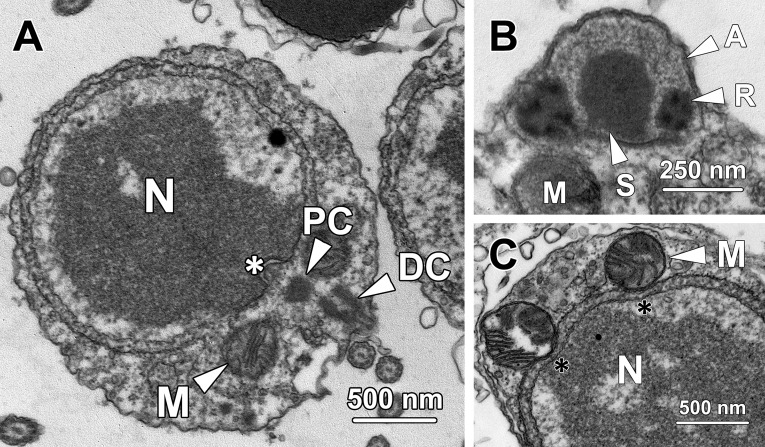
Transmission electron micrographs of step 7 spermatids.(A) The chromatin in the nucleus of step 7 spermatids exhibits a coarse granular form and aggregates into a large irregular-shaped block. The chromatin block attached to the posterior end of the nucleus (N), where an implantation fossa (*, white asterisk) has formed. The proximal centriole (PC) remains in close proximity to the fossa and orientates perpendicularly to the distal centriole (DC). The large spherical-shaped mitochondria (M) become surrounded the centrioles and start to form the mitochondrial sheath at the base of the flagellum. (B) The acrosome (A) transforms into an inverted-bowl shape with its anterior region tightly adherent to the cell membrane. In the acrosomal matrix, both the central sphere (S) and the ring-shaped structure (R) attach to the inner posterior membrane of the acrosome. The acrosome is located adjacent to large spherical mitochondria (M) which will ultimately form the mitochondrial sheath of the flagellum. (C) Where the mitochondria (M) approach the nuclear membrane (N), the nuclear envelope curves inward to form depressions (*, black asterisks).